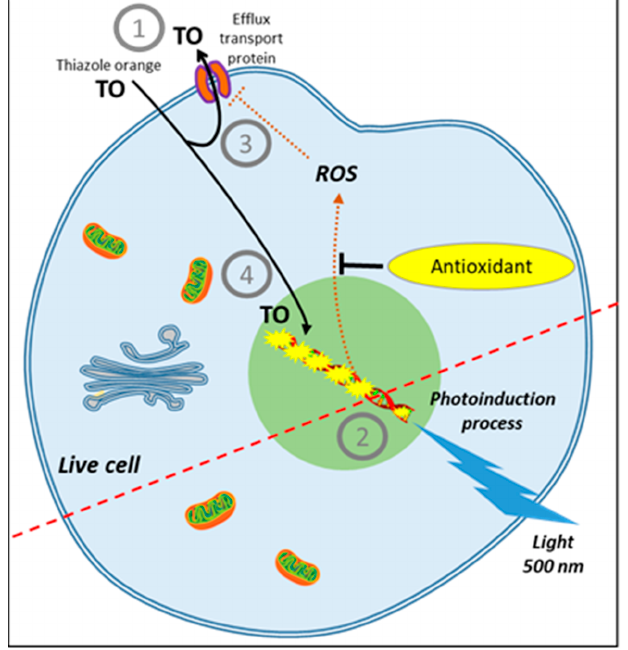
Figure 3. AOP1 assay, live cell antioxidant assay based on photo-induced ROS production. (1) Before photoinduction, TO is massively removed from the cell by efflux transport proteins; (2) photoinduction is initiated by an energy transfer from thiazole orange (TO) to molecular oxygen at the triplet state forming singlet oxygen and subsequent free radicals (ROS); (3) ROS alter TO efflux transport and other cell functions; (4) massive entry of TO triggers an increase in fluorescence emission. Effect is measured as the ability of antioxidants to quench ROS production, keeping TO out of the cell and resulting in low fluorescence. Table 1. Features and limits of the two main live cell assays for the measurement of direct antioxidant effects. CAA Assay AOP1